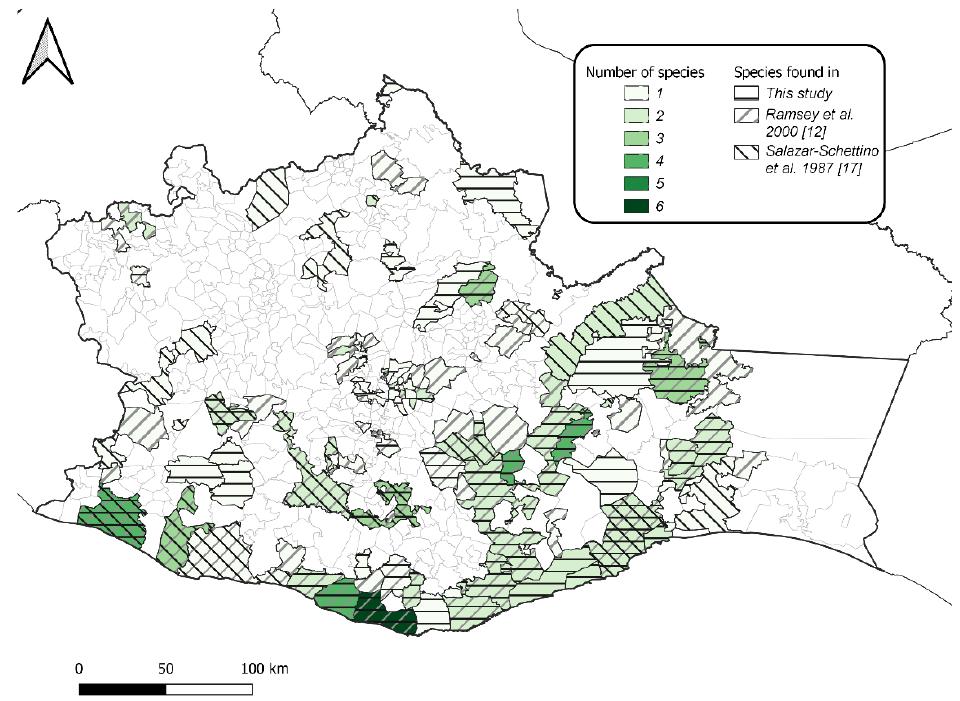
Figure 1. Distribution of the four predominant domestic species of Triatominae in the state of Oaxaca, México: Triatoma barberi, T. dimidiata, T. mazzotti, and T. phyllosoma ; these four, plus T. phyllosoma picturata, Rh. prolixus , T. bolivari, T. gerstaeckeri , T. pallidipennis , and T. nitida , were reported in municipalities in Oaxaca by Salazar-Schettino et al. (1987) [17] and Ramsey et al. (2000) [12].